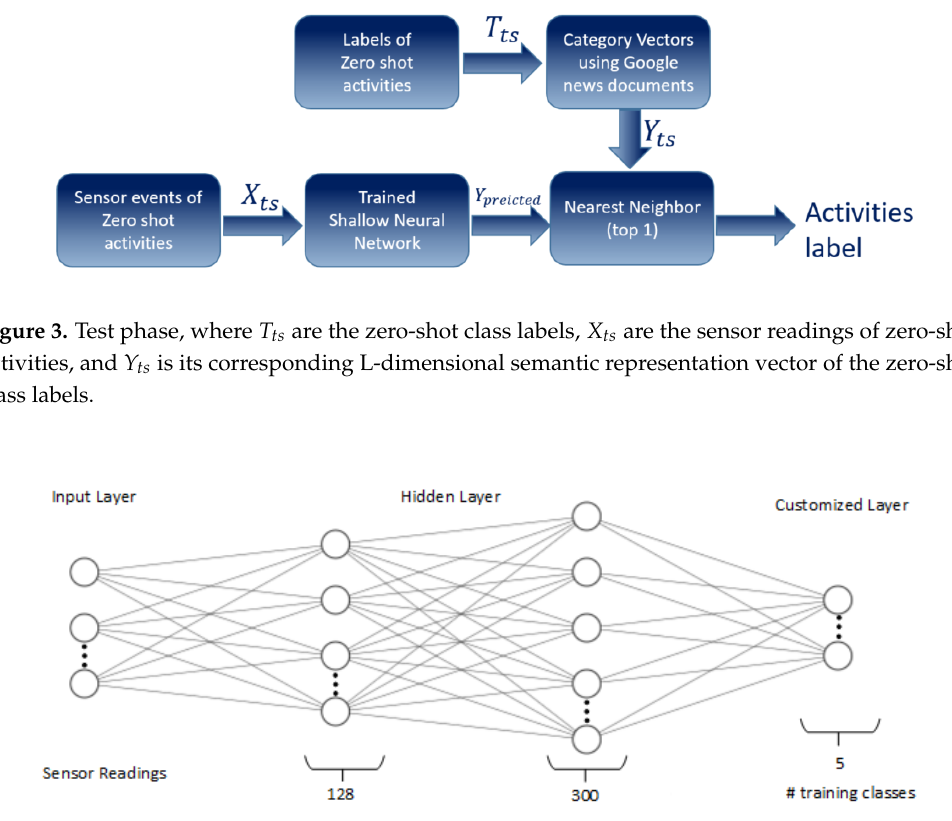
Figure 4. The proposed shallow neural network